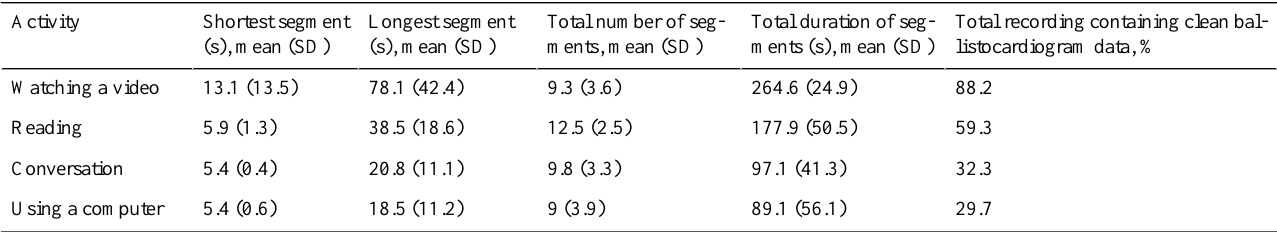
Table 2. Results for four simulated activities for 5 minutes each for 20 participants for segments ≥ 5